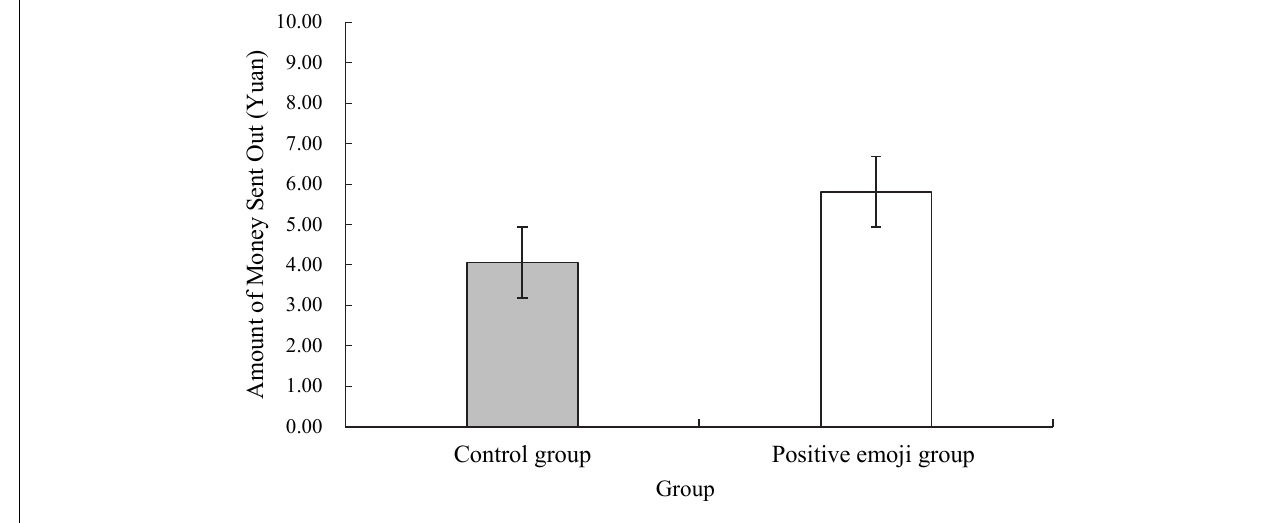
FIGURE 2 | Differences between the amount of money sent by the positive emoji group and the control